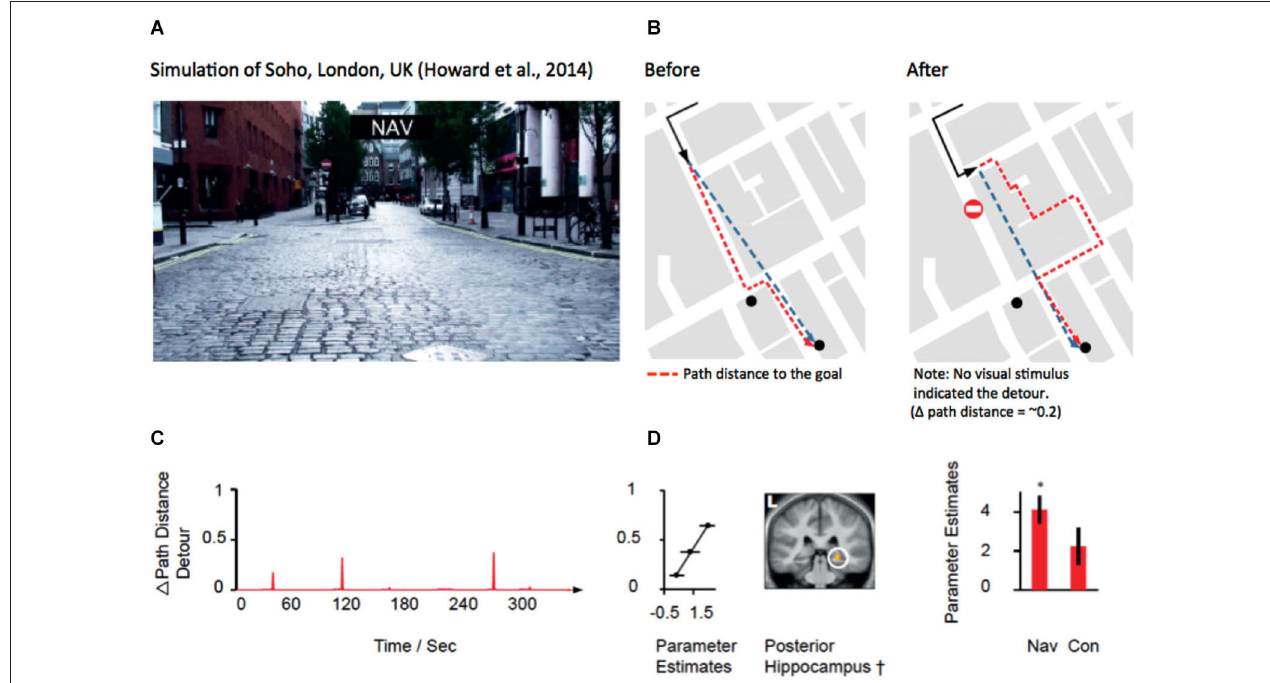
routes navigated in the experiment. (D) Middle: Right posterior hippocampal activity significantly correlated ( p < 0.05 family-wise error corrected) with the change in path distance at detours is plotted on a mean structural scan, thresholded at p < 0.005 uncorrected. Left: Parameter estimates from the peak voxel are plotted for three different ranges of the change in the path distance. Right: parameter estimates of the significant correlation in the navigation condition, but non-significant parameter estimates in the control routes. Note: a significantly greater response was observed in the posterior right hippocampus for navigation routes compared with control routes (see Howard et al., 2014). Images adapted with permission from Howard et al.